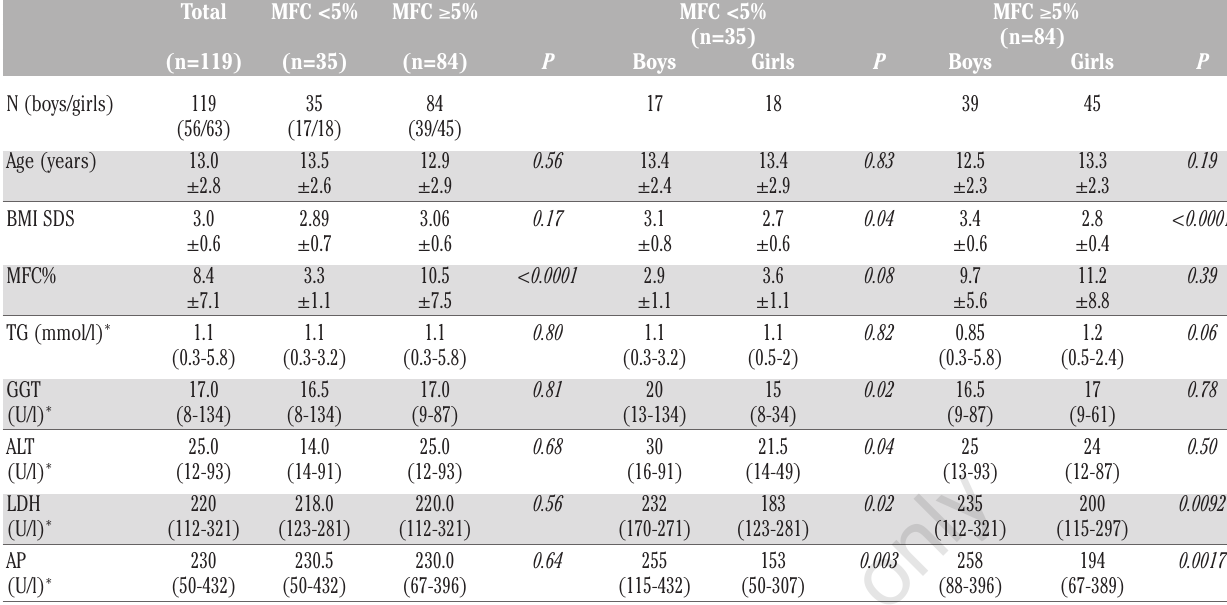
Table 2. Blood values in 119 of the obese children and youths investigated with proton magnetic resonance spectroscopy and magnetic resonance